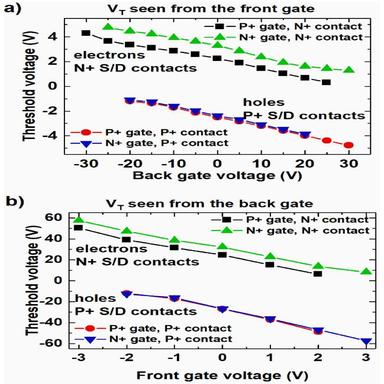
Extracted threshold voltage from devices with P + or N + source/drain contacts and P + or N + poly-Si gate as seen from the a) front-gate b) back-gate.